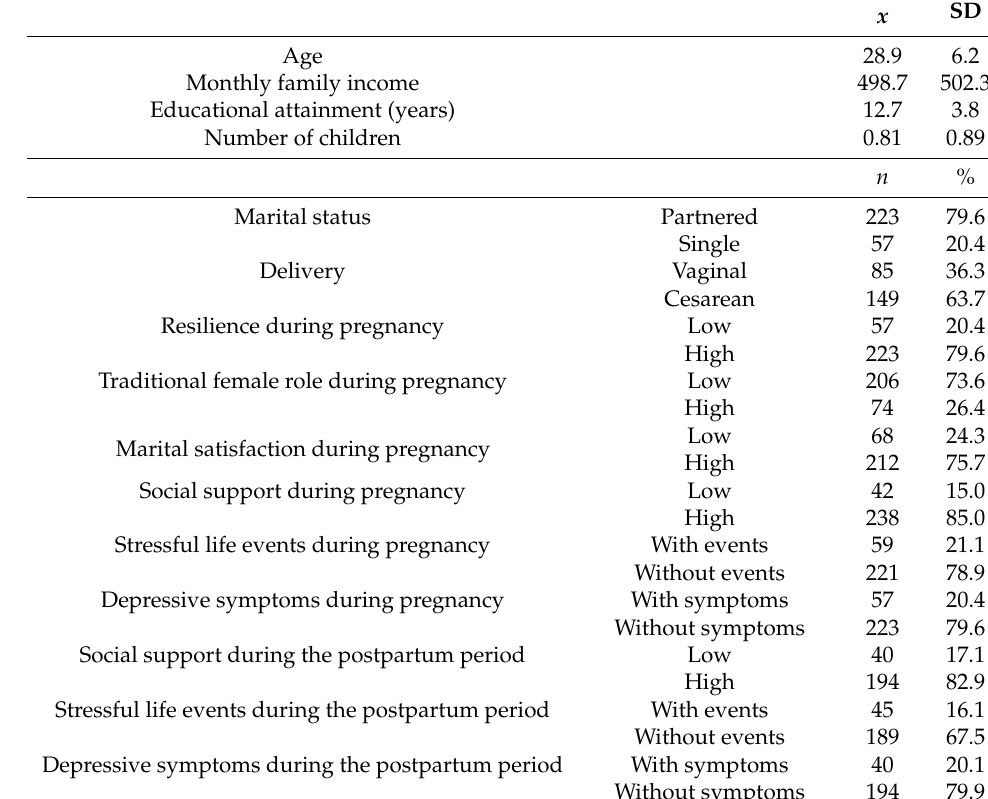
Table 1. Demographic, obstetric, and psychosocial risk factor